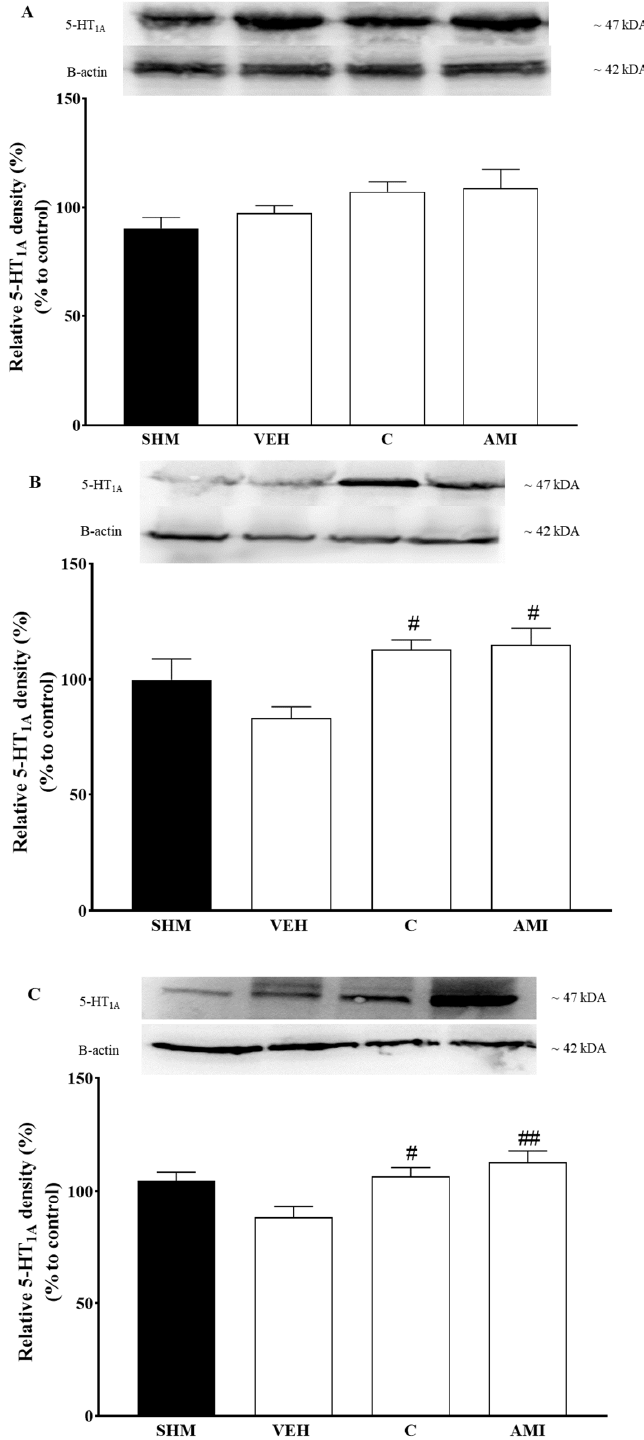
Figure 7. The changes of 5-HT1A protein expression from the: ( A ) Cerebral cortex, ( B ) brainstem, and ( C ) spinal cord were evaluated using western blot. Data presented as mean ± SEM ( n = 4–5), which were normalized to β -actin. # p < 0.05, ## p < 0.01 as compared to vehicle. SHM (Sham); VEH (Vehicle, 10 mL/kg i.p.); C (Cardamonin, 10 mg/kg i.p.); AMI (Amitriptyline, 20 mg/kg i.p.).